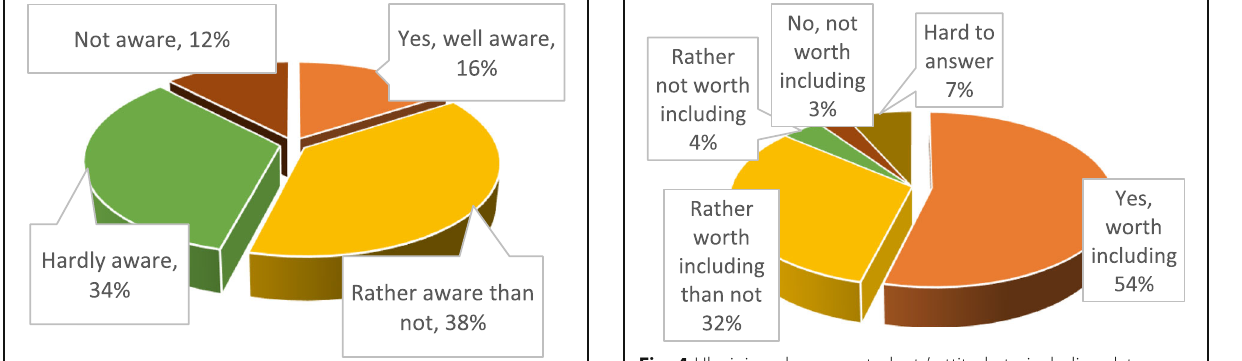
Fig. 2 Awareness by Ukrainian pharmacy students of therapeutic